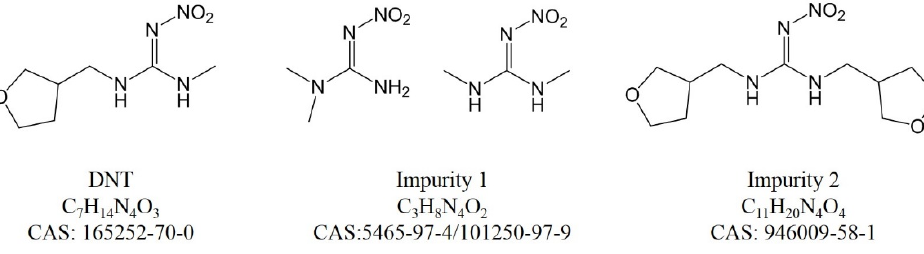
Figure S3: Mass spectra of DNT: (a) MS and (b) MS/MS. Figure S4: Mass spectra of impurity 1: (a) MS and (b) MS/MS. Figure S5: Mass spectra of peak 3: (a) MS and (b) MS/MS. Figure S6: Mass